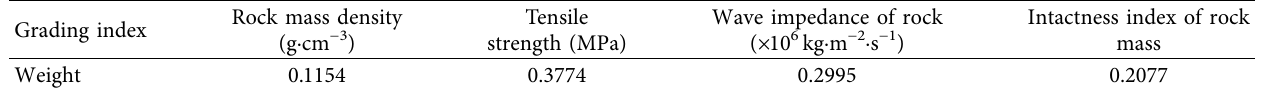
Table 7: Comprehensive weight of rock mass fracturing evaluation index.